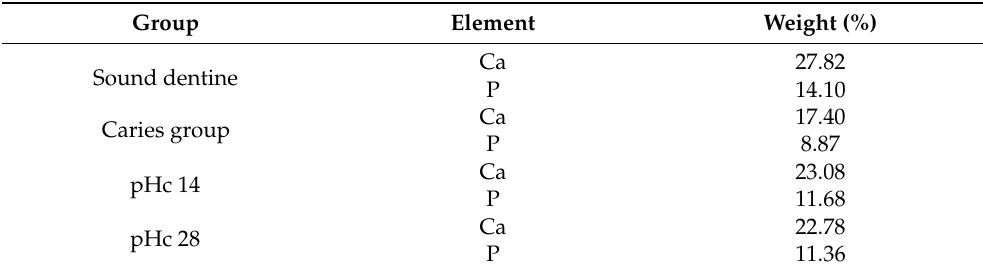
Table 2. The relative concentration of calcium (Ca) and phosphorus (P) on the dentine surfaces expressed as weight % for all experimental groups.